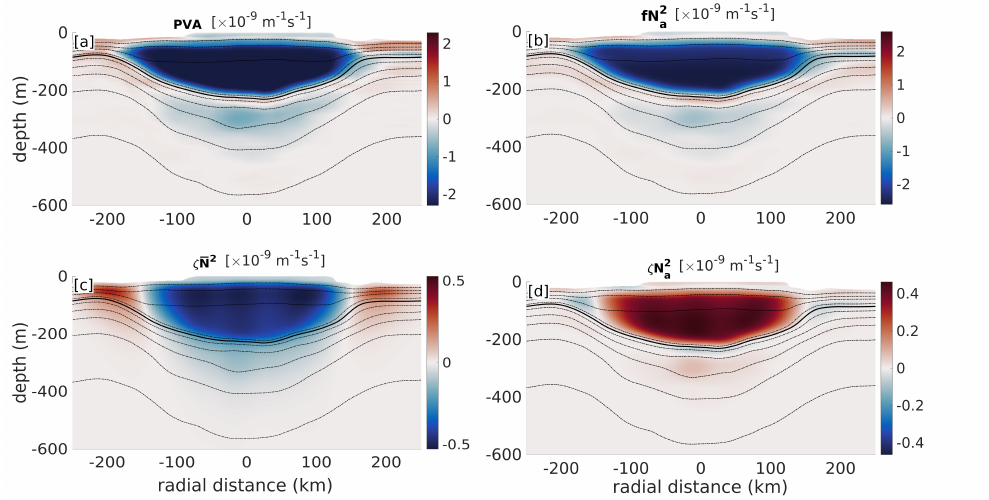
Figure 13. Vertical sections of Ertel’s PV anomaly (PVA) and its contributing terms. ( a ) PVA. ( b ) Stretching term ( f N 2 a ). ( c ) Relative vorticity term ( ζ N 2 ). ( d ) Nonlinear term ( ζ N 2 a